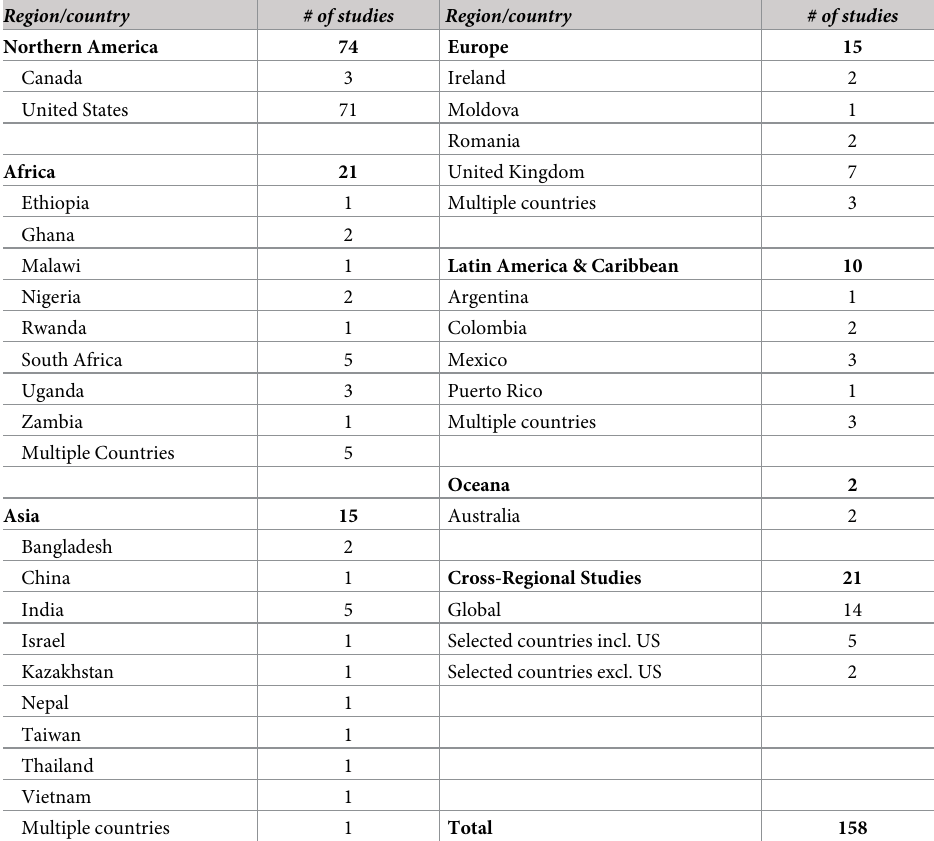
Table 3. Included studies by region and